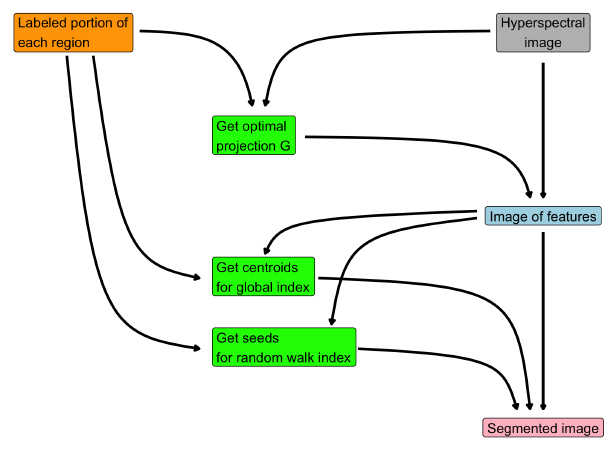
Figure 2. Flow chart of Algorithm